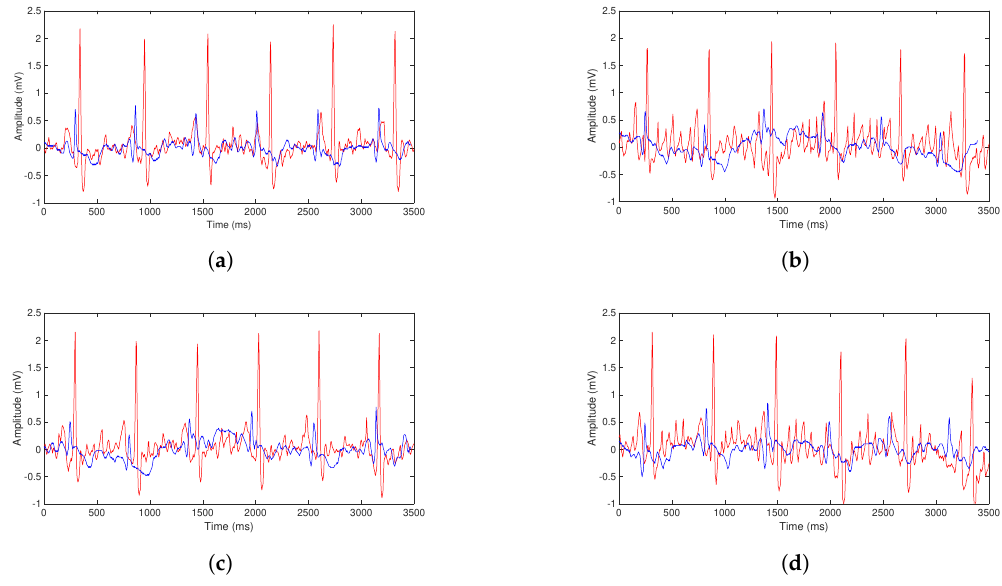
Figure 9. Different ECG deviations from ( a – d ) of the Kardia Mobile (blue) with respect to the MAC800 (red) equipment.